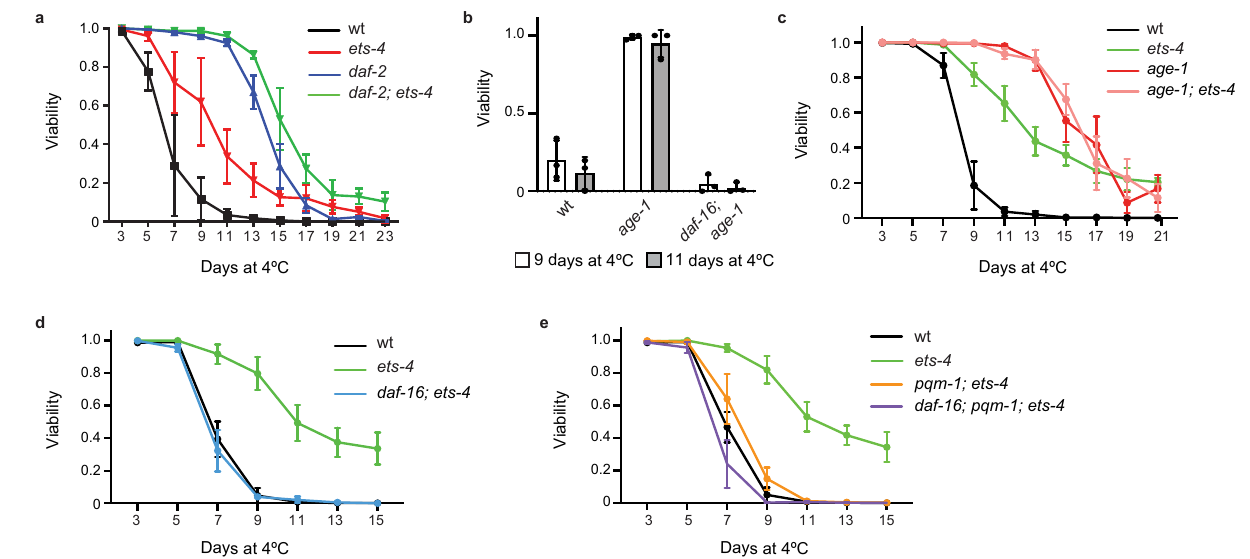
Fig. 2 | The enhanced cold survival of ets-4 mutants depends on DAF-16 and PQM-1. a – e Survival of nematodes of the indicated genotypes, subjected to cold asinFig.1a.Mutantallelesareindicatedinparentheses.ErrorbarsrepresentSEM, “ n ” indicates the number of biologically independent replicates. a Inactivation of ets-4 and daf-2 increases cold survival. Cold resistance was compared between wild type (wt), ets-4(rrr16) , daf-2(e1370) , and daf-2(e1370); ets-4(rrr16) mutants. Notethat daf-2(e1370);ets-4(rrr16) doublemutanthadonlyslightlyimprovedcold resistance compared to daf-2(e1370) single mutant ( p =4.90E-06; Wilcoxon signed-rank test). n =3, 324 – 668 animals scored per time point. b Increased cold resistance of age-1 mutants depends on daf-16 . Cold resistance was compared between wild type (wt), age-1(hx546) , and daf-16(mu86); age-1(hx546) mutants. n =3, 200 – 300 animals scored per time point. c The cold resistance of age-1